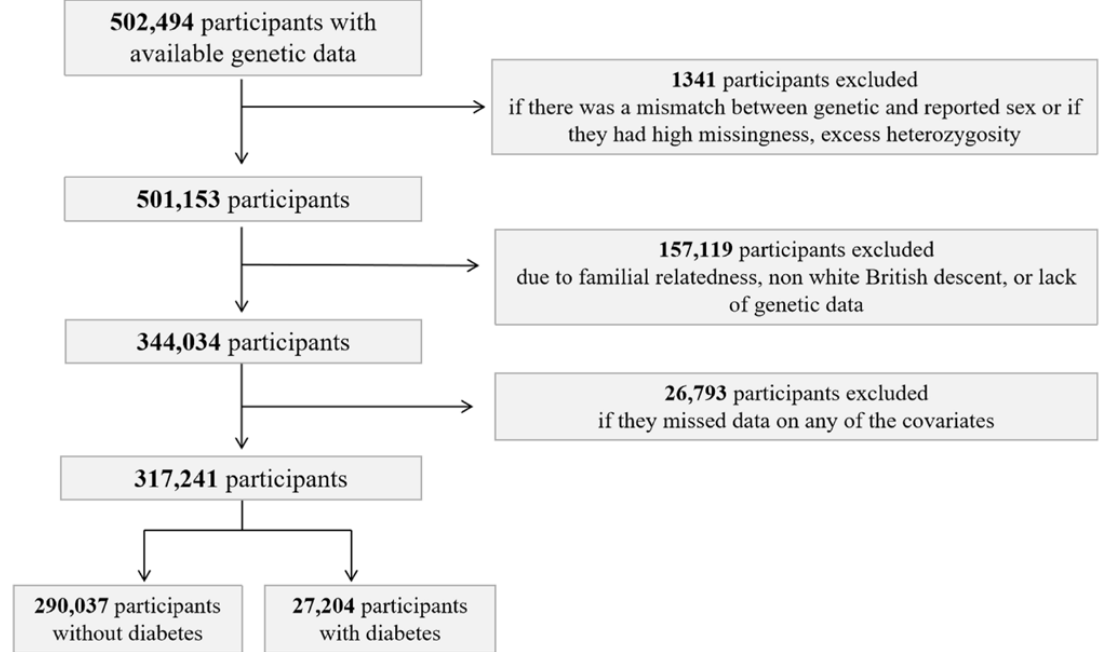
Figure 2. Flowchart of study population selection from the UK Biobank. It depicts the sample selection in the UK Biobank study. Diabetes was defined by having type I, type II, gestational diabetes, or taking anti-diabetic drugs at time of inclusion in the UK Biobank.